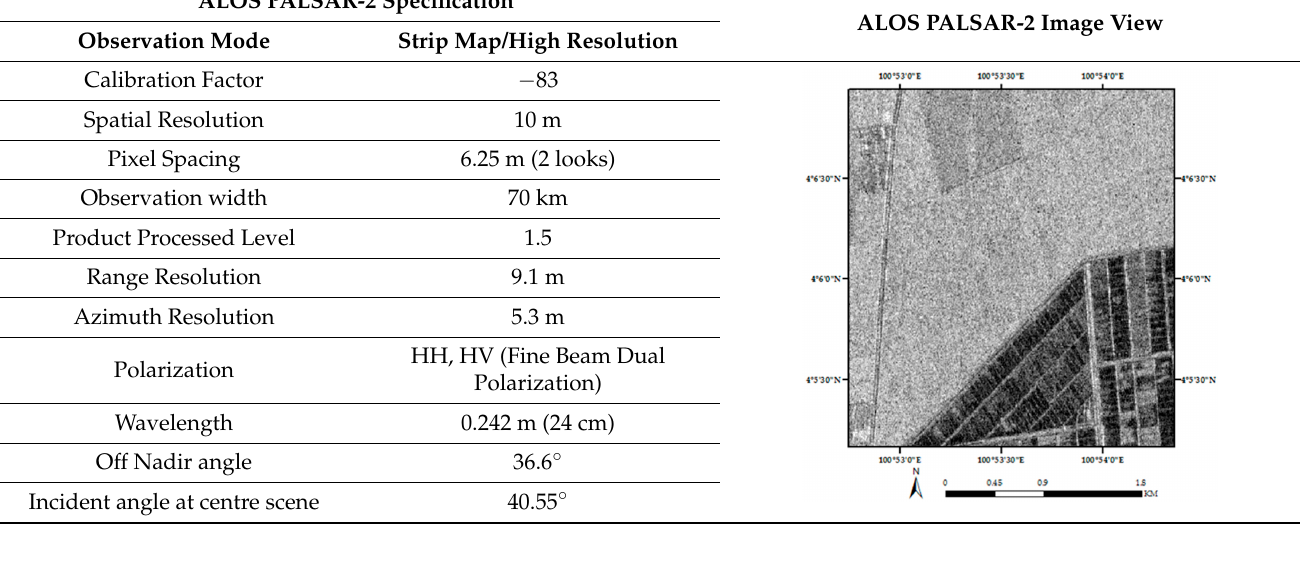
Table 2. Details specification and image view of ALOS PALSAR-2.